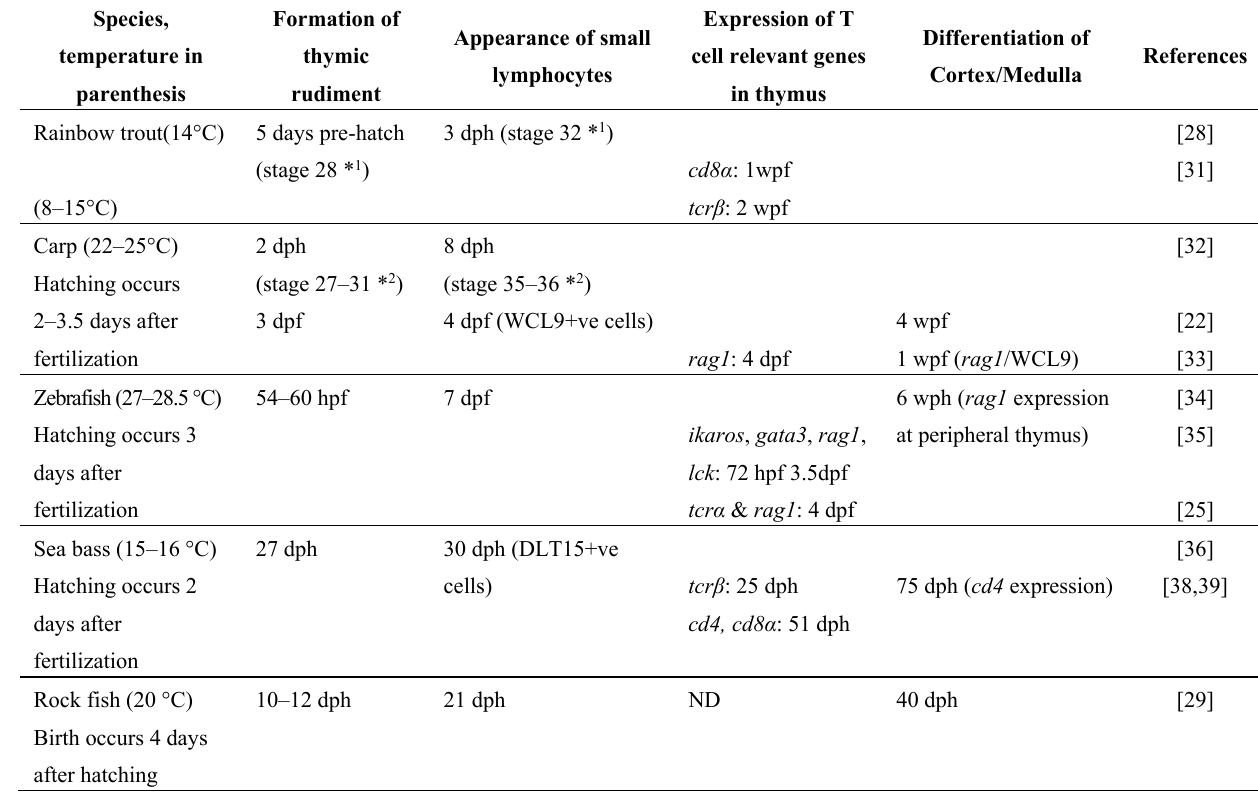
Table 1. Development of thymus and T cells in